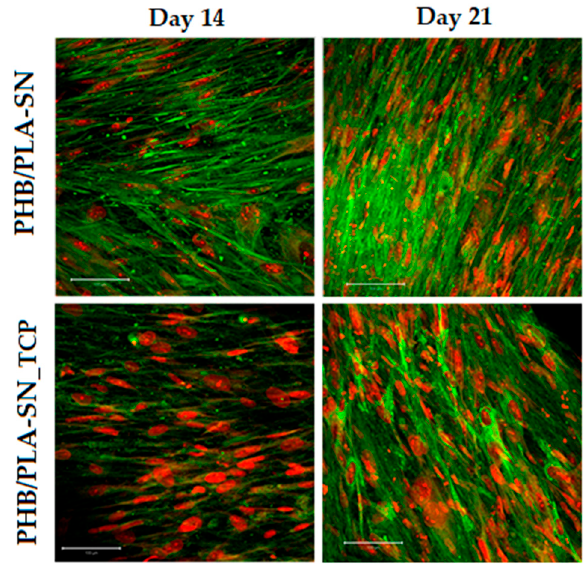
Figure 10. Collagen I staining, cell nuclei are red and collagen is green, magnification 200×, the bar is 100 µm.